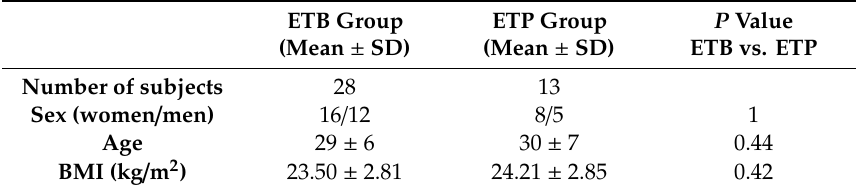
Table 2. Comparison of baseline phenotypes of ETB and ETP subjects.